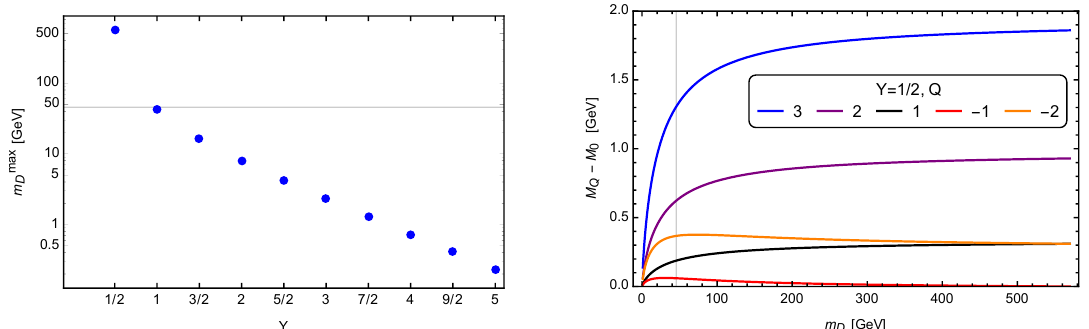
Figure 1. Left: maximum value of m D above which the lightest component has charge Q = − 1 for various values of Y . The horizontal line indicates m 2 , below which decays of the Z exclude the Z / model. Right: spectrum for a generic multiplet with Y = 1 / 2 , with m 570 GeV. The vertical D < line shows m 2 , below which the model is excluded by the Z D ≈ m Z /